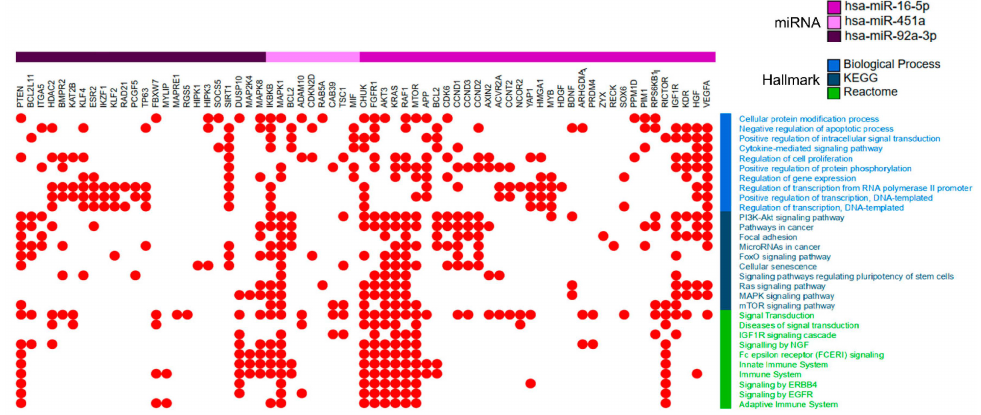
Figure 4. Pathways regulated by genes targeted by miRNAs. Each miRNA is shown associated with their specific target genes, in the above color bar: miR-16-5p (purple color), miR-92a-3p (violet), and miR-451a (light pink). Pathways shown in the figure were selected among the top 10 most significant, enriched pathways ( q -value < 0.01, FDR < 0.05) and that included at least 10 participating genes in each pathway. The red dots indicate the respective pathway(s) in which genes are involved. Biological process (light blue), KEGG (dark blue) and Reactome (green) hallmarks are in the right